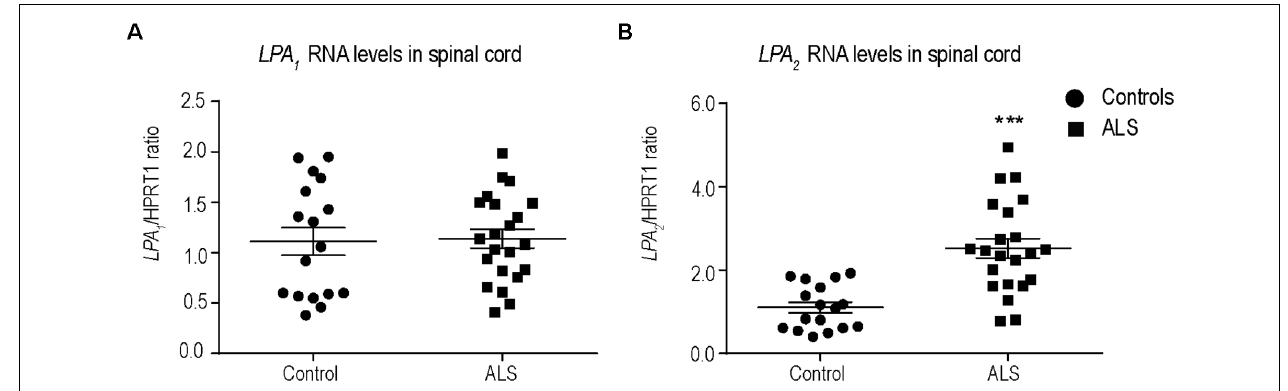
FIGURE 1 | Characterization of Lysophosphatidic acid 1 ( LPA 1 ) and LPA 2 expression in the spinal cord of sporadic amyotrophic lateral sclerosis (sALS) patients. (A,B) Plots showing RNA levels of LPA 1 (A) and LPA 2 (B) in the spinal cord of sALS patients ( n = 22) and controls ( n = 17). Unpaired t -test. Data are shown as mean ± SEM. *** p < 0.001.